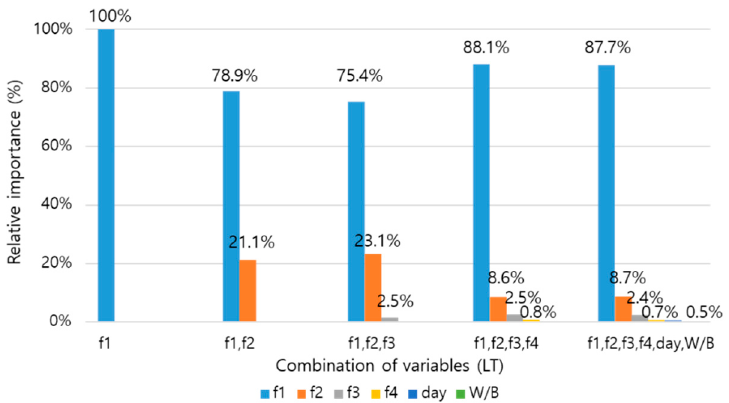
Figure 12. Relative importance according to combination of variables in LT mode.